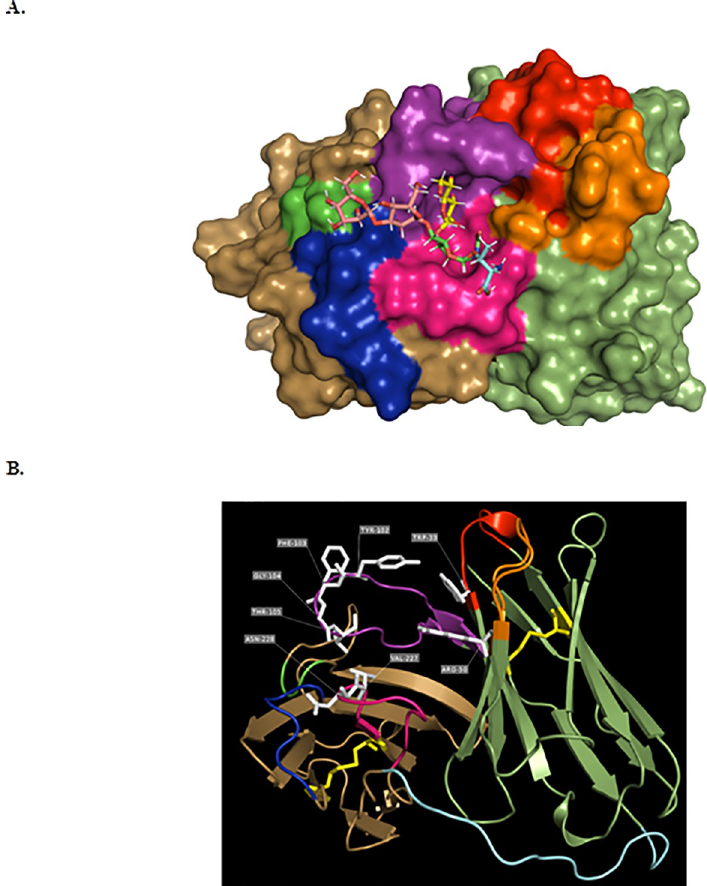
two molecules using Hex 8.0 software. β -D-galactofuranose(1–4)N-acetylglucosamine is represented by the sticks model, while scFv-10D8 is represented by the surface model for better visualisation of the antigen-binding site. Panel b represents scFv-10D8 in a VH-linker-VL format, highlighting the β -sheets, turns and flexible regions. In yellow are the cysteine residues and the disulfide bonds that are critical for the antibody